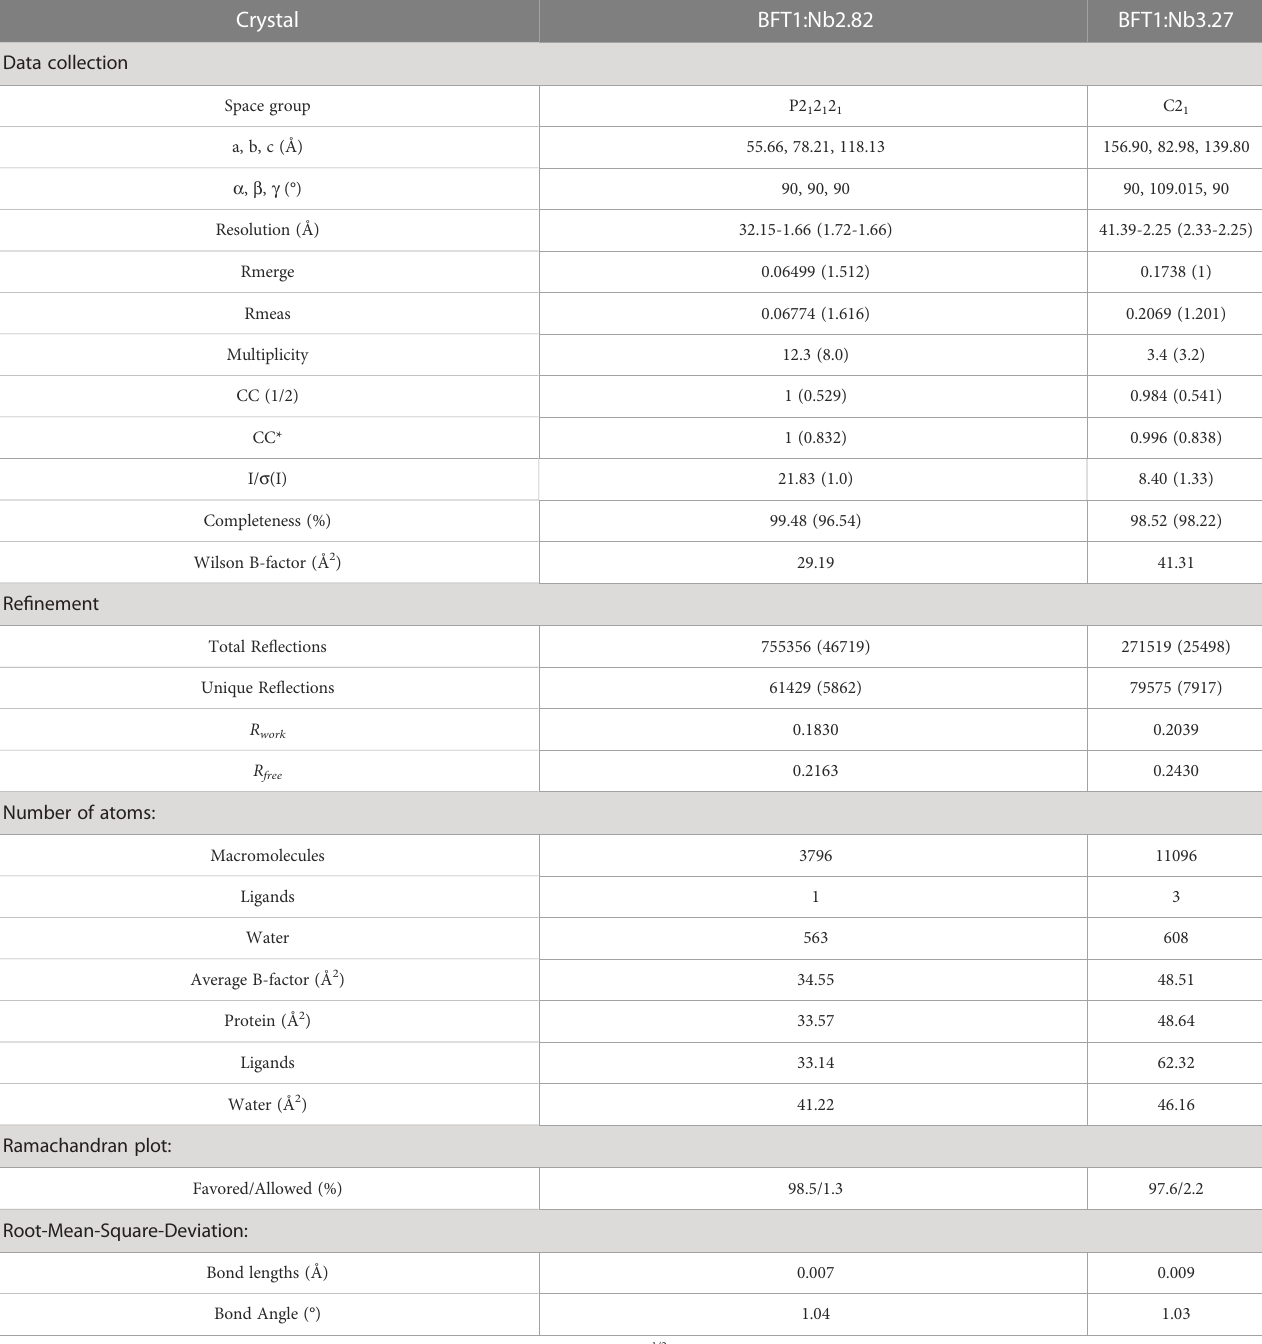
TABLE 1 X-ray data collection and re fi nement